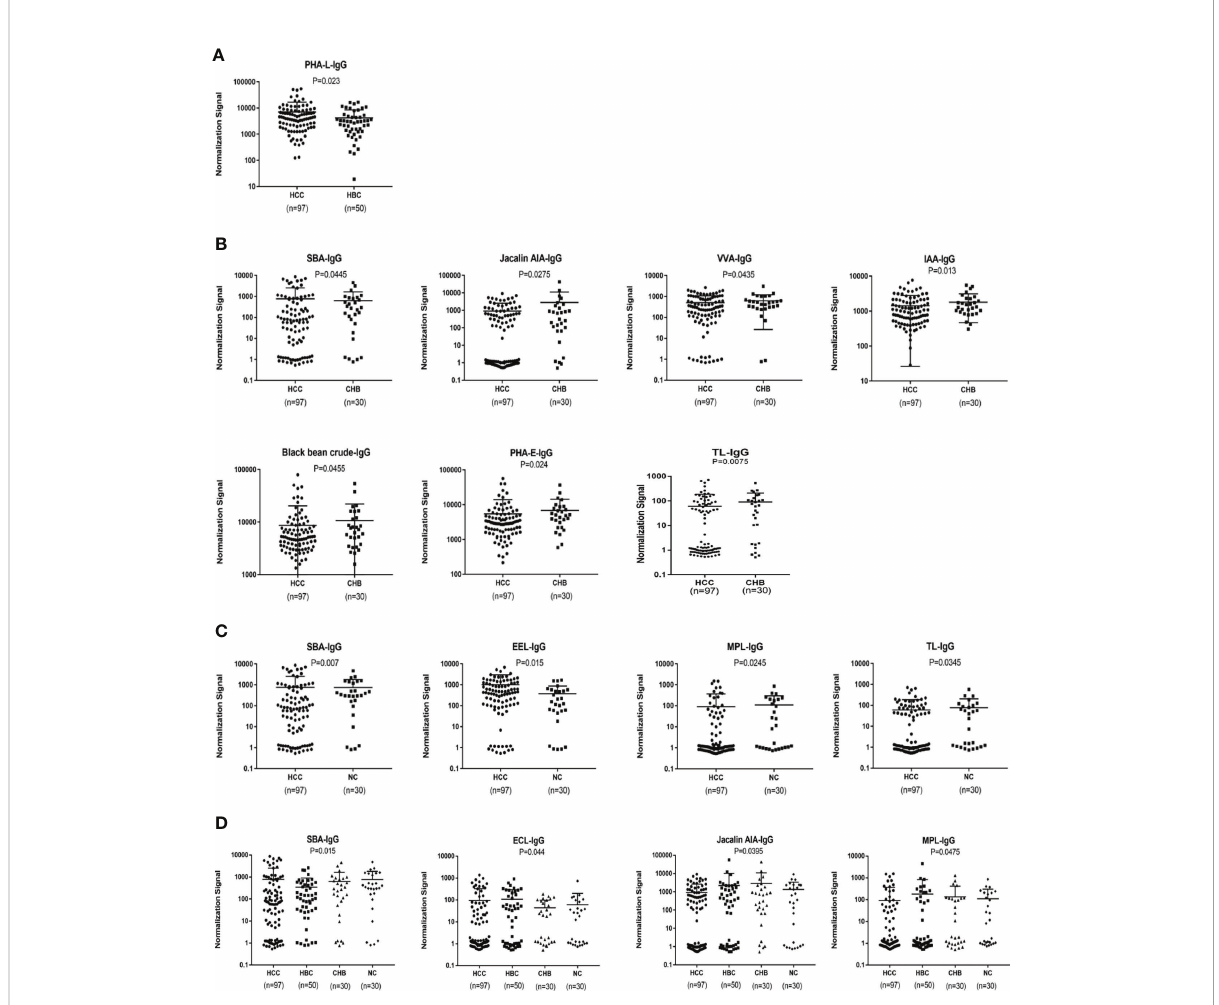
FIGURE 3 Speci fi c lectins of serum IgG detected by a lectin microarray. (A) Speci fi c differences in serum IgG glycosylation between HCC and HBC. (B) Speci fi c differences in serum IgG glycosylation between HCC and CHB. (C) Speci fi c differences in serum IgG glycosylation between HCC and NC. (D) Speci fi c differences in serum IgG glycosylation among HCC, CHB, HBC, and